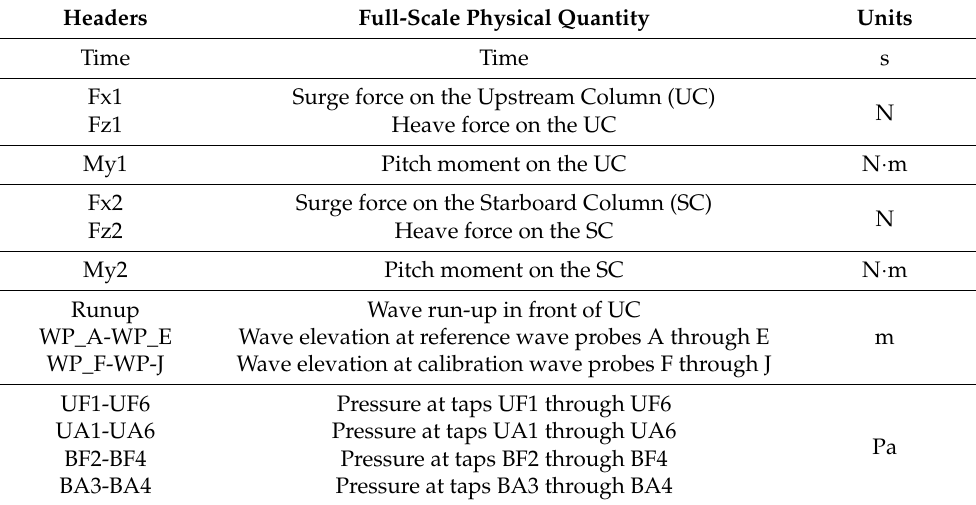
Table 5. Experimental measurements included in the OC6 Phase Ib